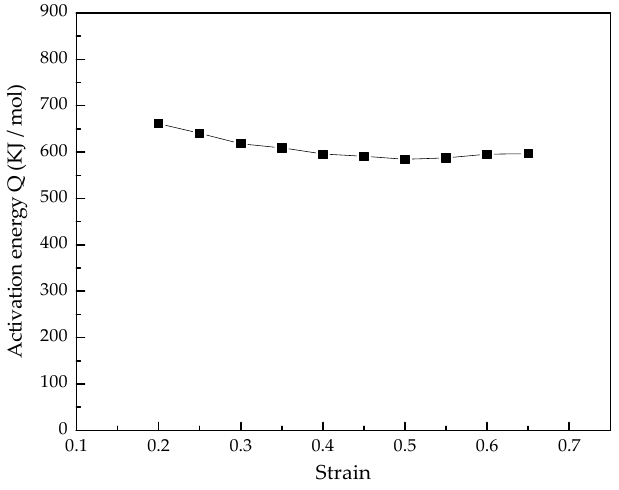
Figure 9. Activation energy of deformation of Ti–3.3Al–1.5Zr–1.2Mo–0.6Ni alloy. After the deformation activation energy is determined, multiple regression analysis is performed on Equation (11), and each coefficient is shown in Table 1.